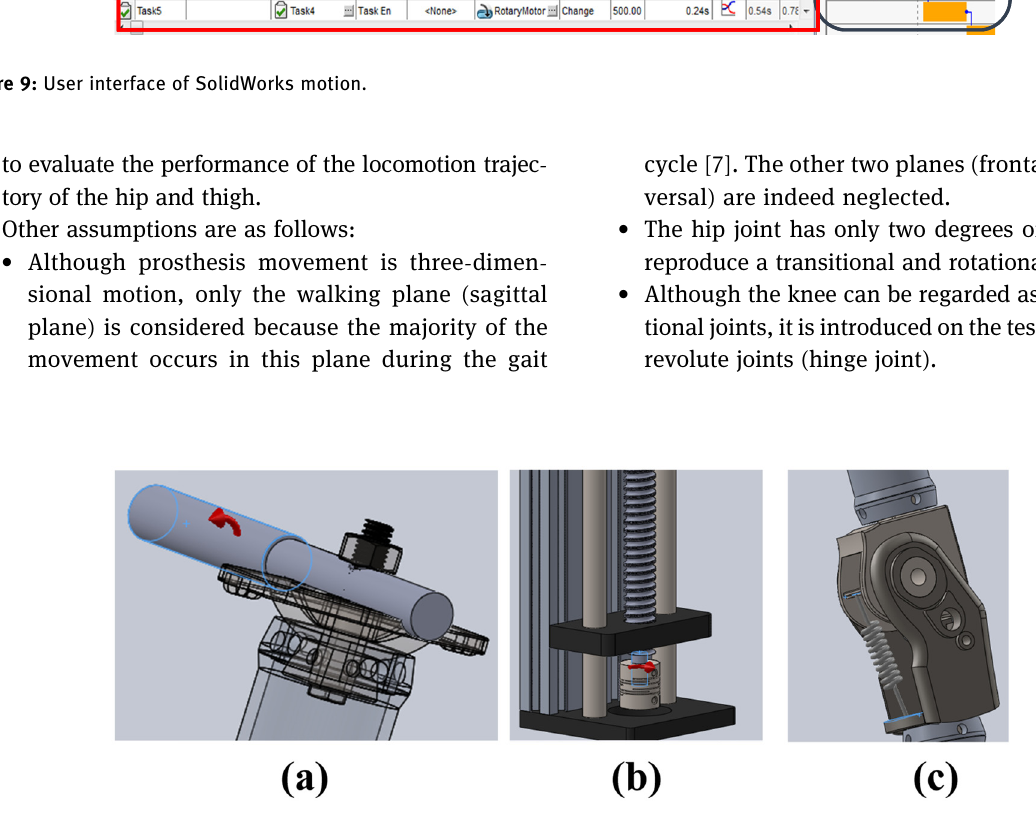
Figure 10: ( a ) Rotary motor for shaft rod, ( b ) rotary motor for ball - screw, and ( c ) axial spring force for knee